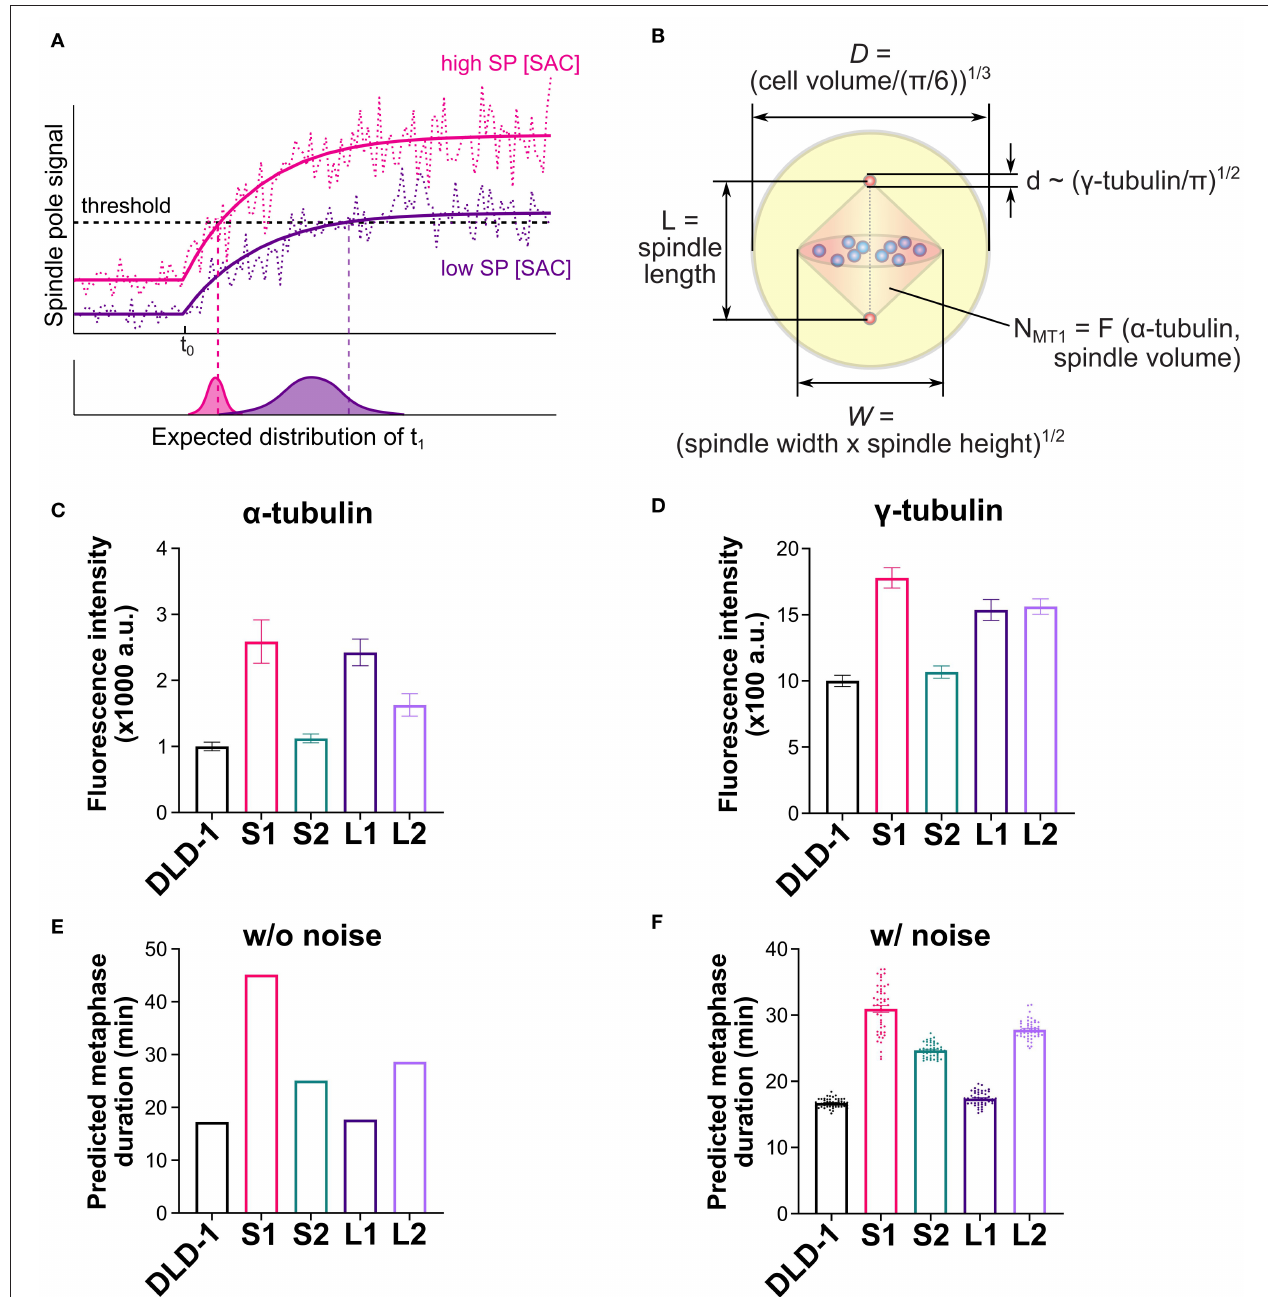
FIGURE 6 | Mathematical model explains observed metaphase durations when combining cell/spindle dimensions with tubulin measurements. (A) Effects of spindle pole signal level on predicted metaphase duration. A higher overall level of the spindle pole signal (magenta line) is expected to trigger SAC silencing earlier than a lower level does (purple line). Noise (dashed lines) is expected to expedite triggering of SAC silencing and cause variation in the triggering time, and both effects are expected to be more significant with lower spindle pole signal level. (B) Dimensions of cell, spindle and spindle pole, and abundance of microtubules calculated from experimental measurements (refer to the Supplementary Materials for the derivation of microtubule number, N MT 1 ). (C) Experimentally measured α -tubulin intensity in the parental DLD-1 cells and the 4N DLD-1 clones. (D) Experimentally measured γ -tubulin intensity in the parental DLD-1 cells and the 4N DLD-1 clones. (E,F) Metaphase durations predicted for the parental DLD-1 cells and the 4N DLD-1 clones using the dimensions shown in panel (B) without (E) and with (F) noise. Values of the dimensions are given in Table 1 . Scatter dots in panel (F) show 50 individual simulation results and bars show the average.